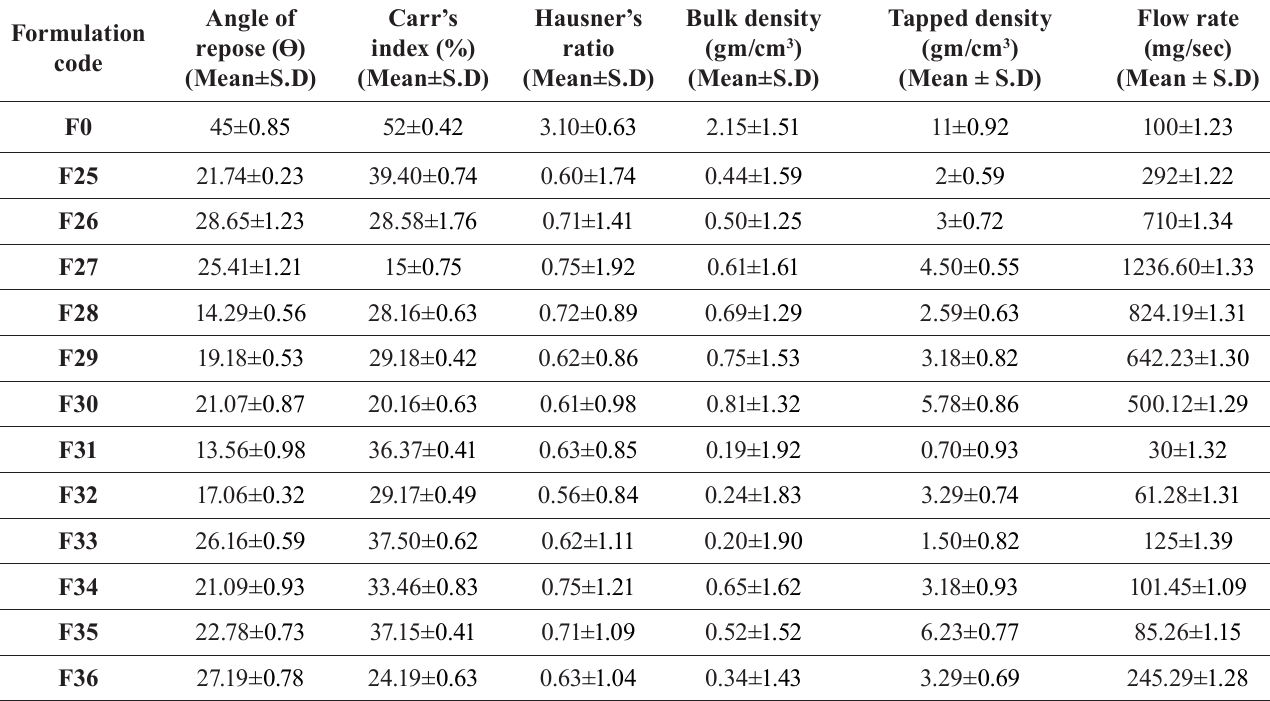
TABLE VI - Micromeretic properties data of pure drug and selected inclusion complexes formulations prepared by co- evaporation method, Data expressed as mean ± S.D. (n=6)